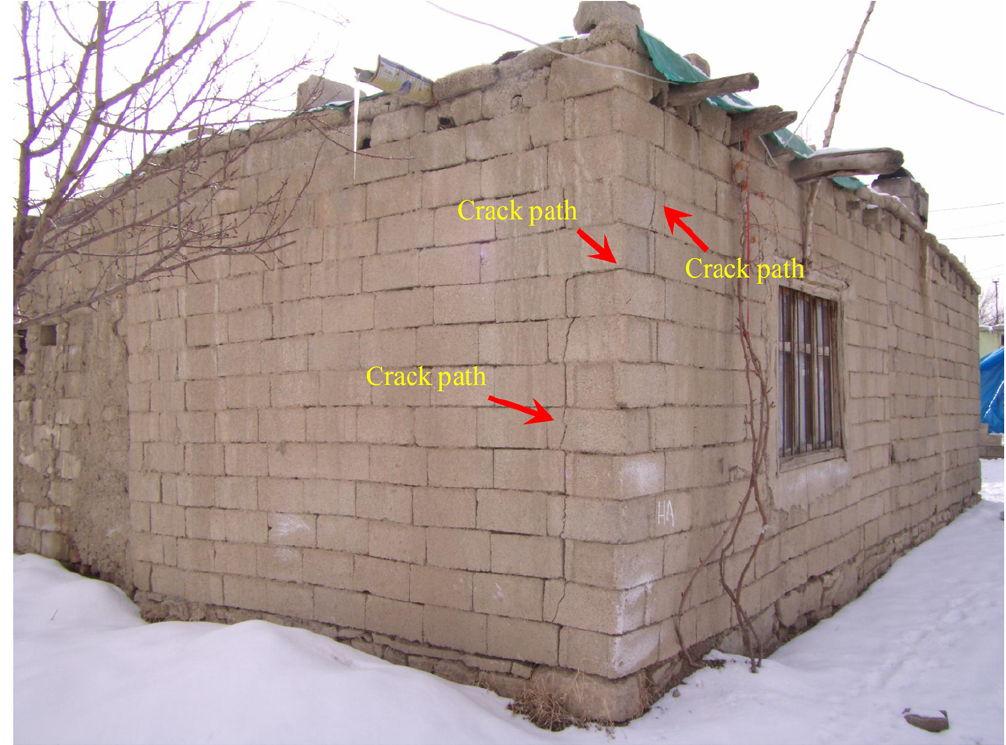
Fig. 23. Crack propagated from one wall to the other in perpendicular direction at the building corner.